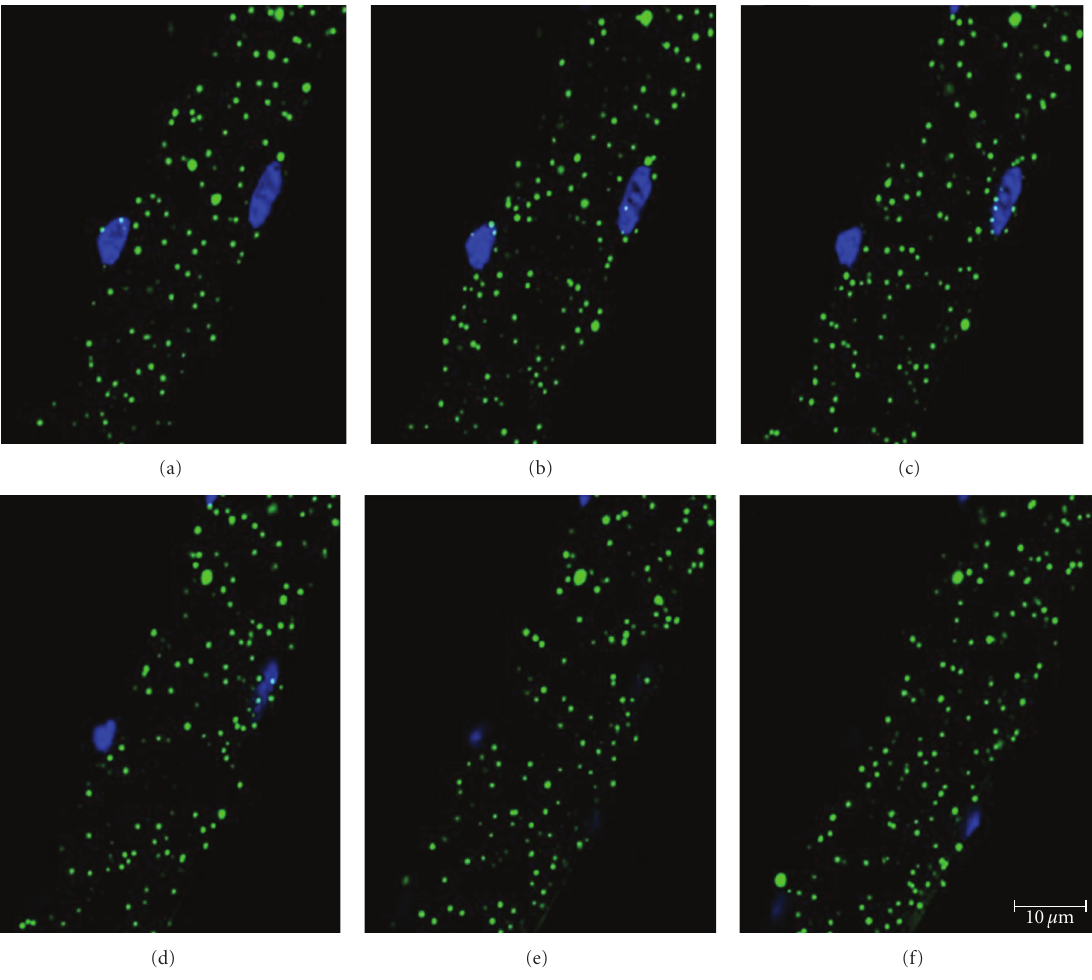
Figure 6: Z-stack analysis of a mouse single muscle fiber treated overnight with palmitate-oleate-supplemented media demonstrates distribution of LDs throughout the entire muscle fiber. Single muscle fibers isolated from the FDB were doublly stained with BODIPY (493/503-green) and DAPI (blue). Consecutive 1- µ m-thick confocal images are shown from Z-stacks taken near the middle of the fiber (63x), and scale bar is provided for